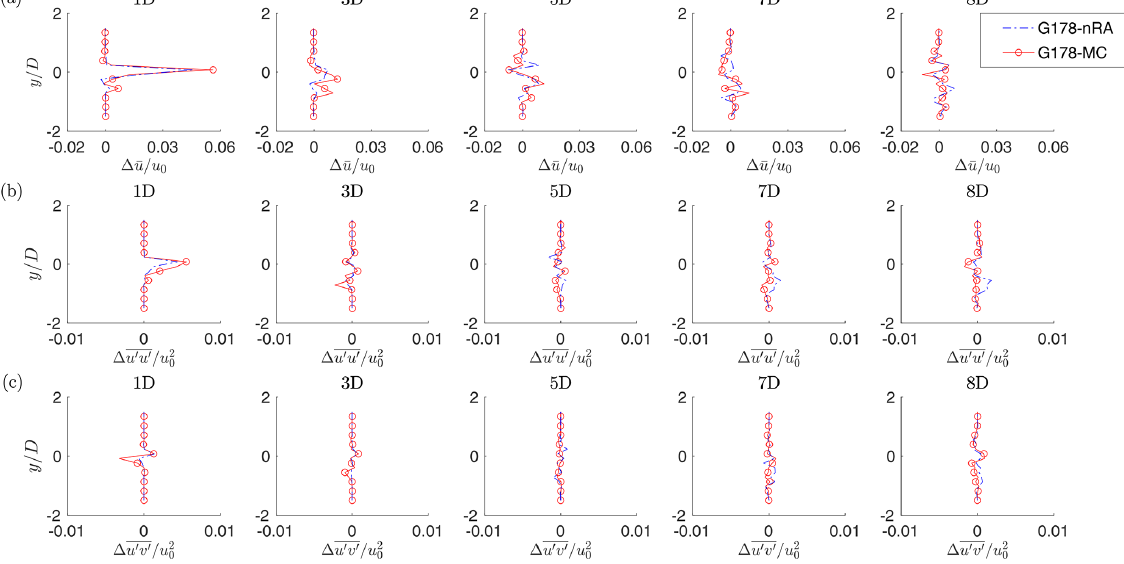
Figure 12. Difference in the profiles of the normalized time-average streamwise velocity (a) , normal stress (b) and shear stress (c) along hub-height horizontal lines, in yaw misaligned and medium-TI conditions. Dash-dotted blue line: effect of rotational augmentation, i.e., G178 results subtracted from G178-nRA results. Red solid line and ◦ symbols: effect of mismatched circulation close to the root, i.e., G178 results subtracted from G178-MC